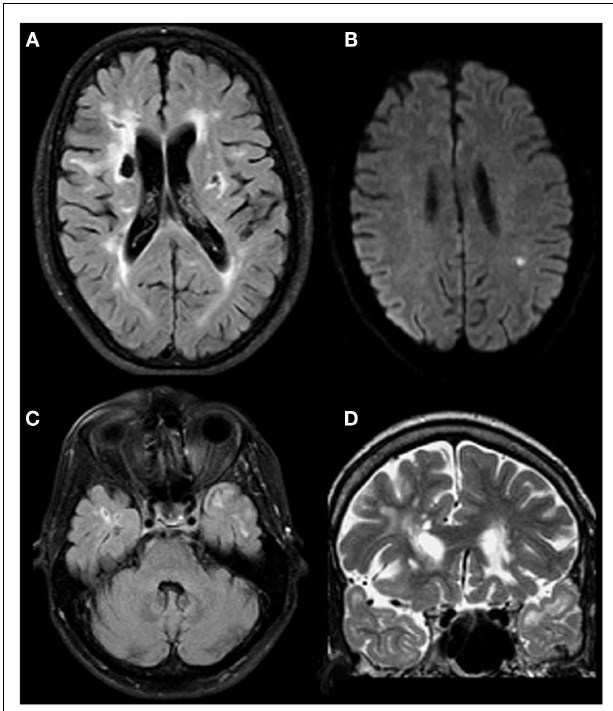
FIGURE 1 | Both chronic and acute changes in a patient with proven CADASIL . Chronic lacunar defects and gliotic changes affecting bilateral fronto-parietal regions including basal ganglia on both sides [ (A) ; axial FLAIR image]. Subacute lacunar infarct in the left parietal white matter [ (B) ; axial diffusion weighted image]. Gliotic changes affecting both anterior temporal lobes are thought to be typical for CADASIL [ (C,D) ; axial FLAIR and coronalT2 weighted images; please note: lacunar defects in the right temporal lobe are adjacent to the right-sided